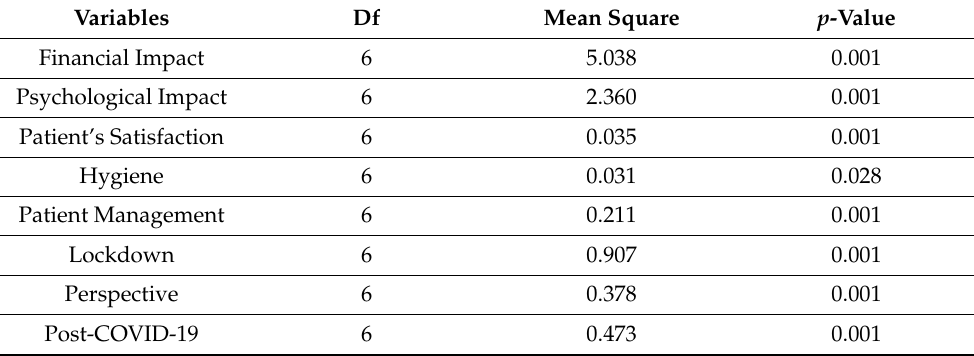
Table 8. Comparison of experience with dental